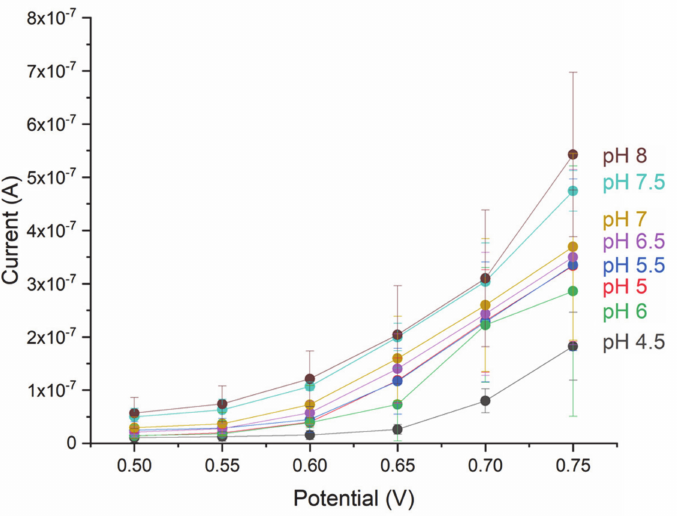
Figure 4. Current response of GOx functionalized Au electrode at different pH values ( n = 3). n = number of analyzed samples.